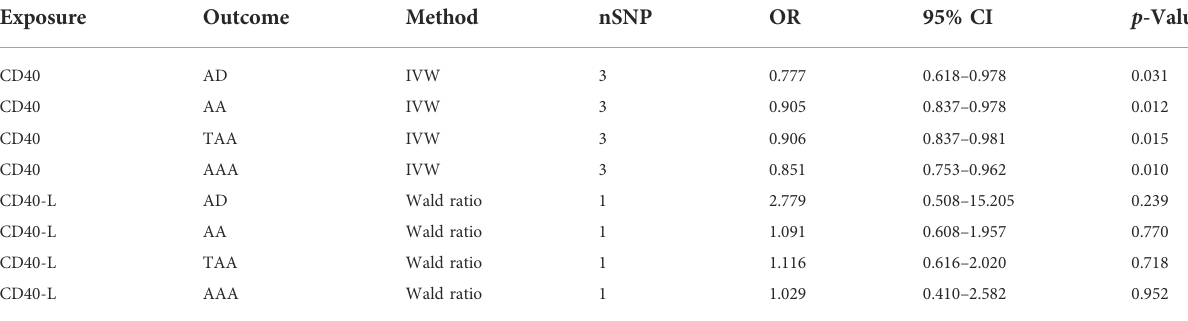
TABLE 2 Two-sample MR analyses of associations between CD40/CD40L and aortic diseases.